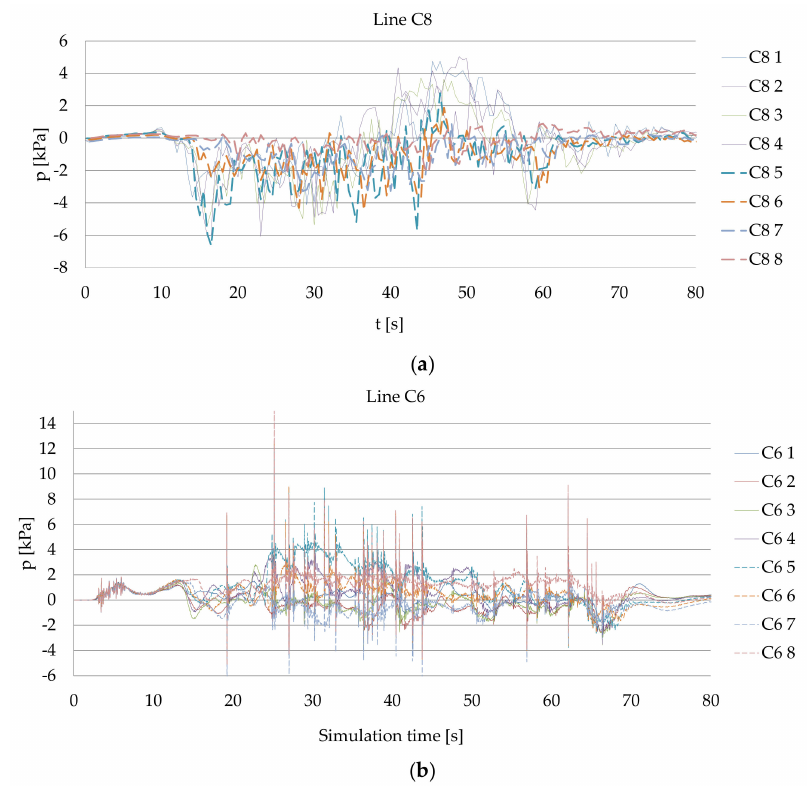
Figure 7. Pressure during the unberthing: ( a ) real measurements for Ferry 2 in the C8 line; ( b ) CFD simulation for Ferry 2 results in the C6 line corresponding to the C8 line during the measurements, both the bow thrusters operating with 130 kN thrust each during the period of time of 60